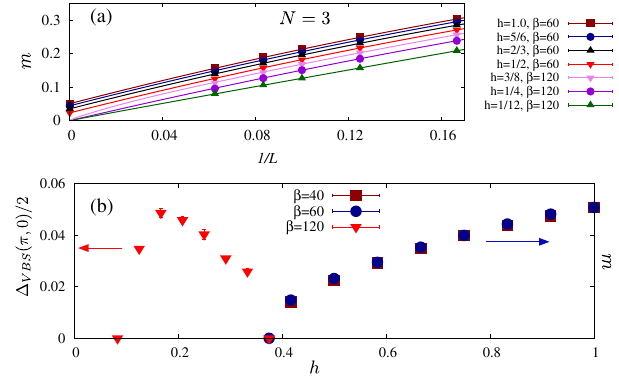
FIG. 15. (a) SU(3)-spin staggered moment as a function of system size. The data are consistent with the following choices of fit functions. For h > 3 = 8 , we have used a second-order poly- nomial in 1 =L . At h ¼ 3 = 8 , we have fitted the data to the form m ð L Þ ¼ aL − ð 1 þ η Þ = 2 to obtain η ≃ 0 . 64 , which turns out to be substantially larger than the exponent obtained for the J-Q model for the SU(3) case, η ≃ 0 . 4 [54]. For lower values of h , we again use a polynomial fit and impose a zero intercept with the y axis. In panel (b), we plot the extrapolated value of the magnetization as well as of the VBS order parameter. At h ¼ 3 = 8 , both VBS and AFM order parameters are consistent with a power-law decay.